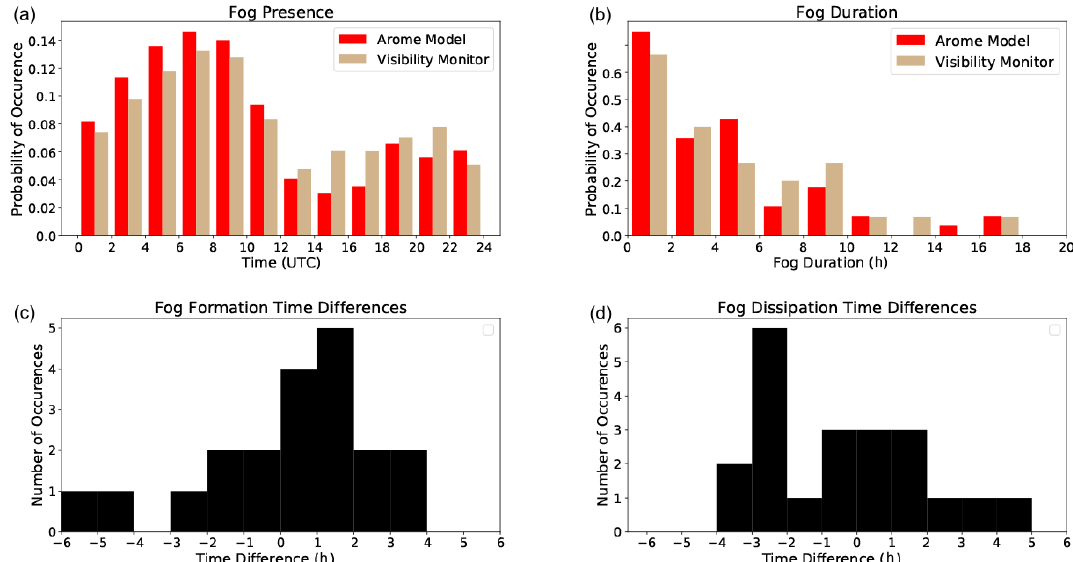
Figure 3. (a) – (d) Times at which fog was observed (brown bars) and predicted by AROME model (red bars); duration of fog events observed and predicted by the model; fog formation time differences for matching events; fog dissipation time differences for matching events (differences are positive where fog forms or dissipates later in the